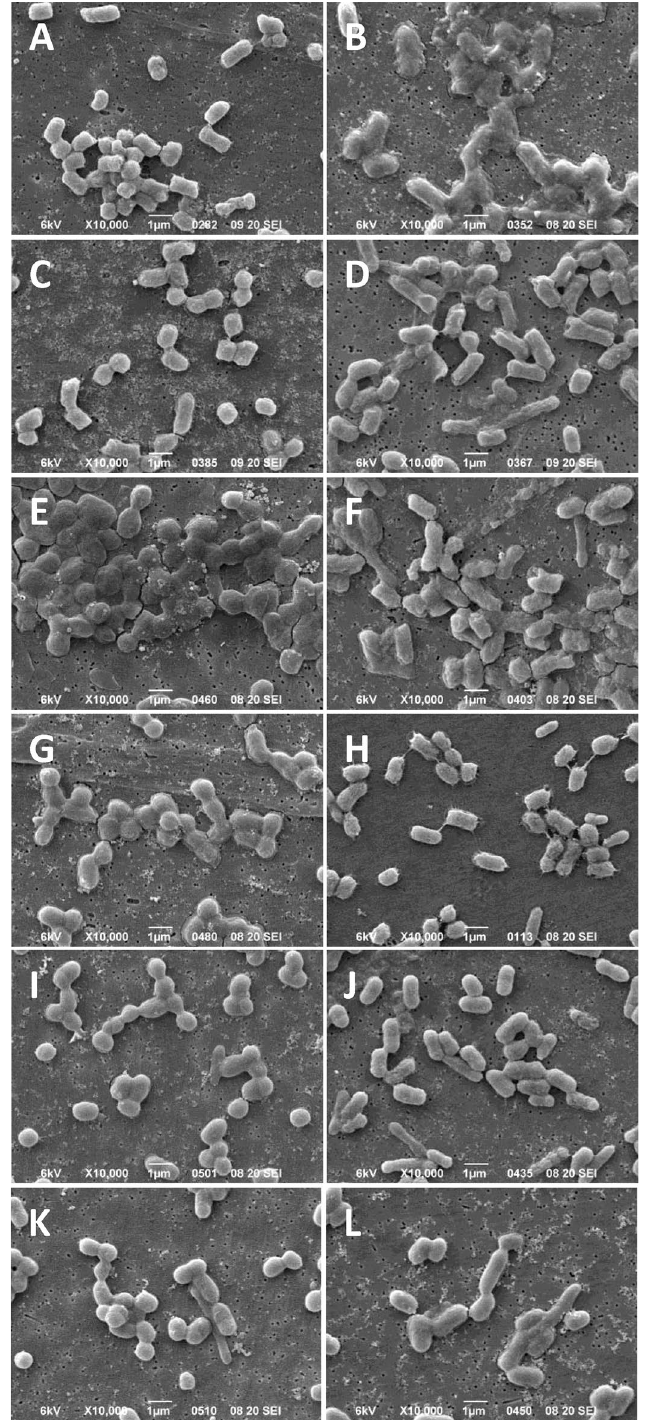
Figure 3. SEM images of E. coli K-12 BW25113 WT and CHXR1 replicates after 30-min exposure to increasing concentration of CHX. ( A , C , E , G , I , K ) shows WT cells and ( B , D , F , H , J , L ) show CHXR1 cells after 30-min exposure to CHX at 0 µg/mL ( A , B ), 1 µg/mL ( C , D ), 2 µg/mL ( E , F ), 10 µg/mL ( G , H ), and 32 µg/mL ( I , J ), 64 µg/ mL ( K , L ). All images are representative of 5 SEM images collected at ×10,000 magnifications and the white scale bar at the bottom of each panel image indicates 1 µm lengths. Images from the same bioreplicated culture preparation are